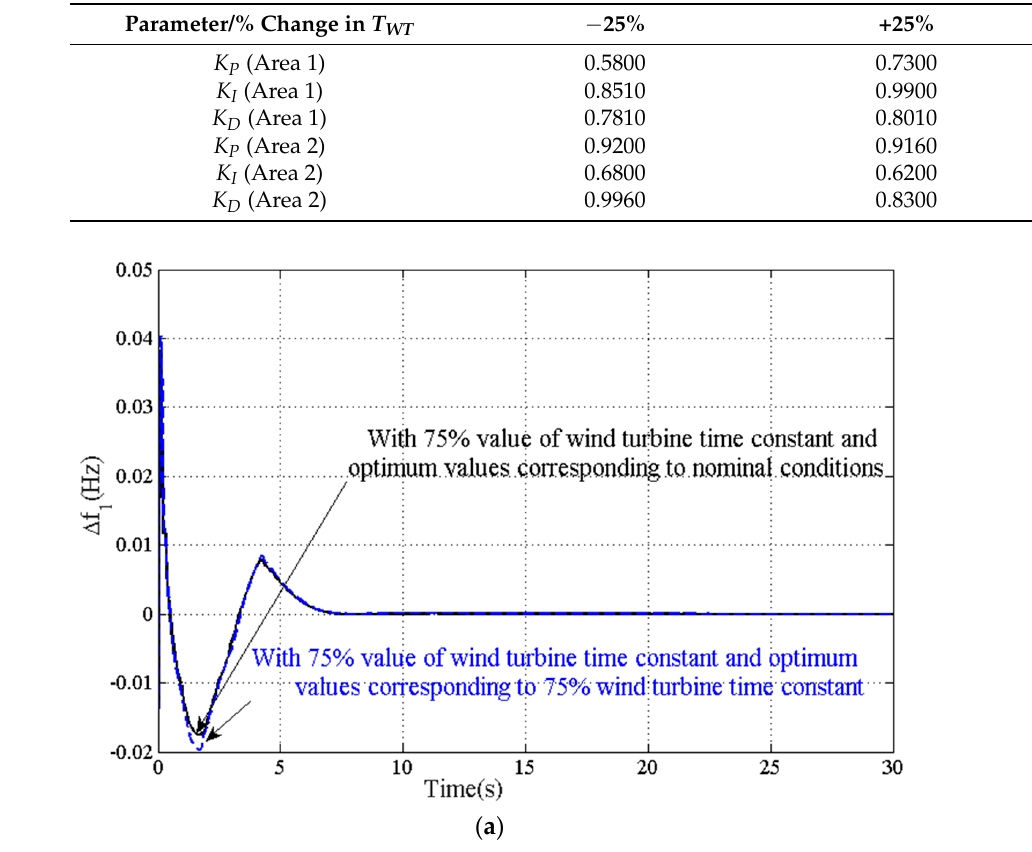
Table 6. The SAO-PID gains for ±25% deviations in T WT .